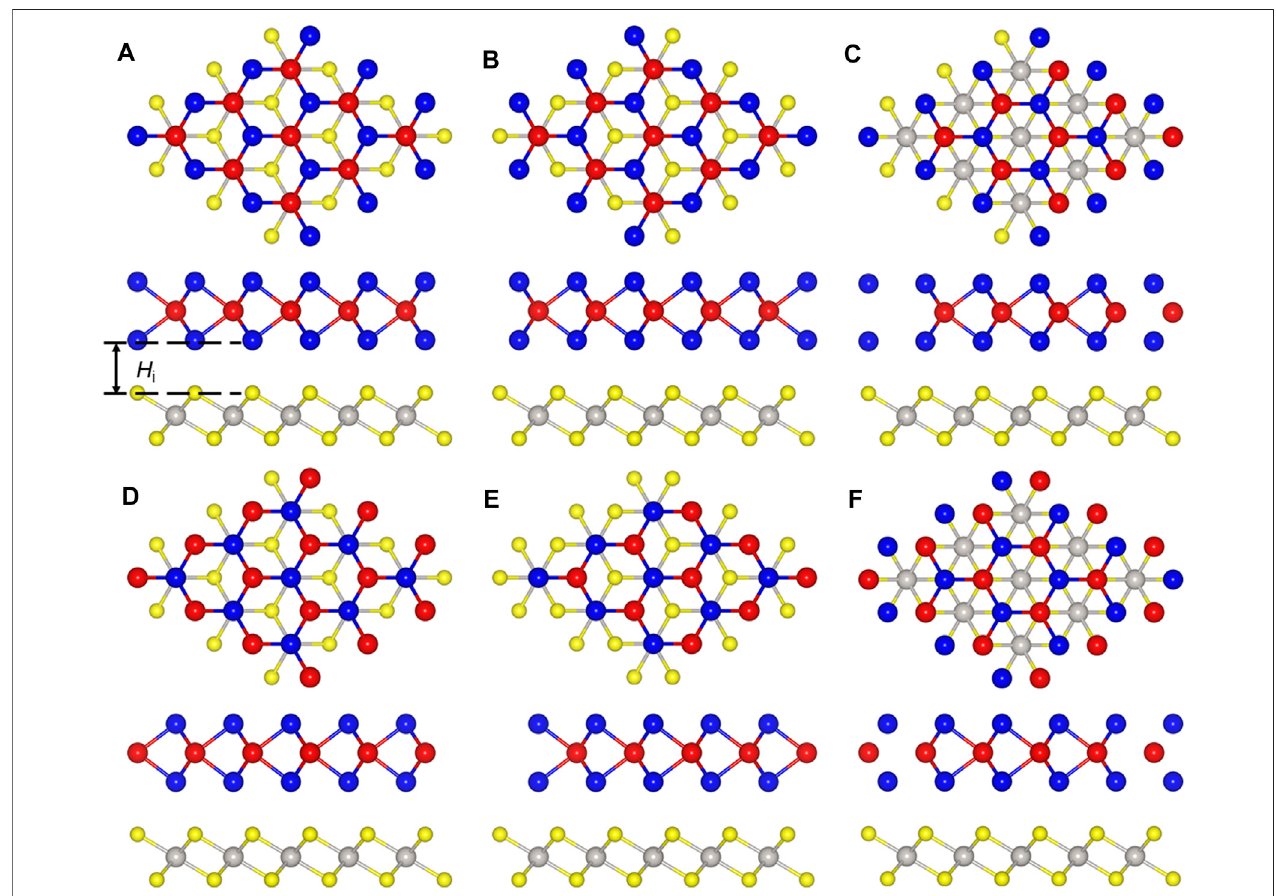
FIGURE2| Thestackingstyles ofthePtS 2 /MoTe 2 heterostructureconstructed by (A) PM-1, (B) PM-2, (C) PM-3, (D) PM-4, (E) PM-5,and (F) PM-6,respectively.